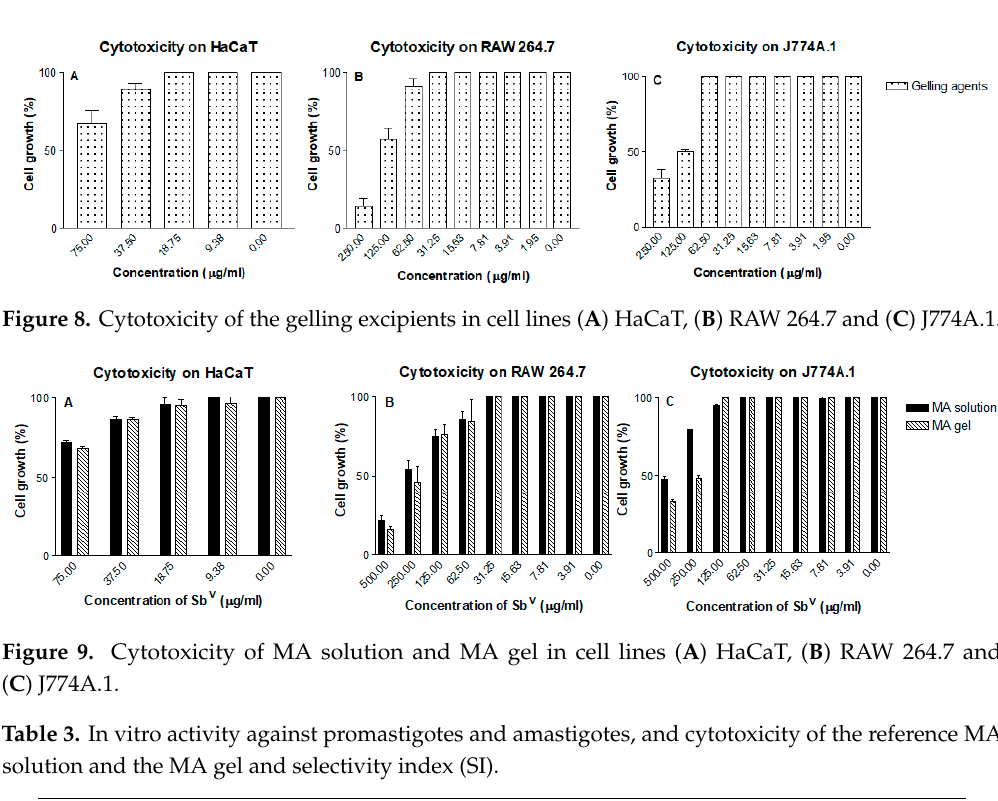
Table 4. In vitro activity against promastigotes and amastigotes, and cytotoxicity of the gel alone and selectivity index